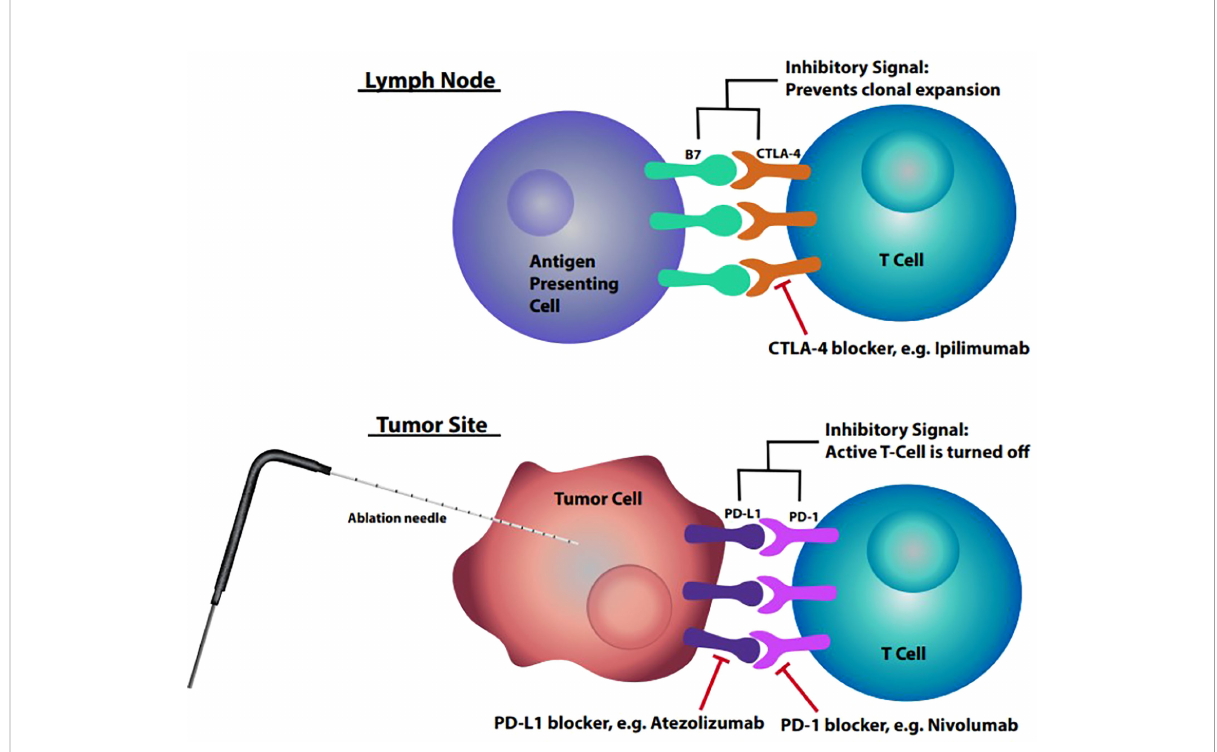
FIGURE 1 Lymph node: Interaction between B7 found on antigen presenting cell and CTLA-4 on T cells within the lymph nodes resulting in inhibitory signal preventing clonal expansion. Tumor site: Interaction between upregulated PD-L1 on tumor cells and PD-1 on T cells resulting in inhibitory signal deactivating the T